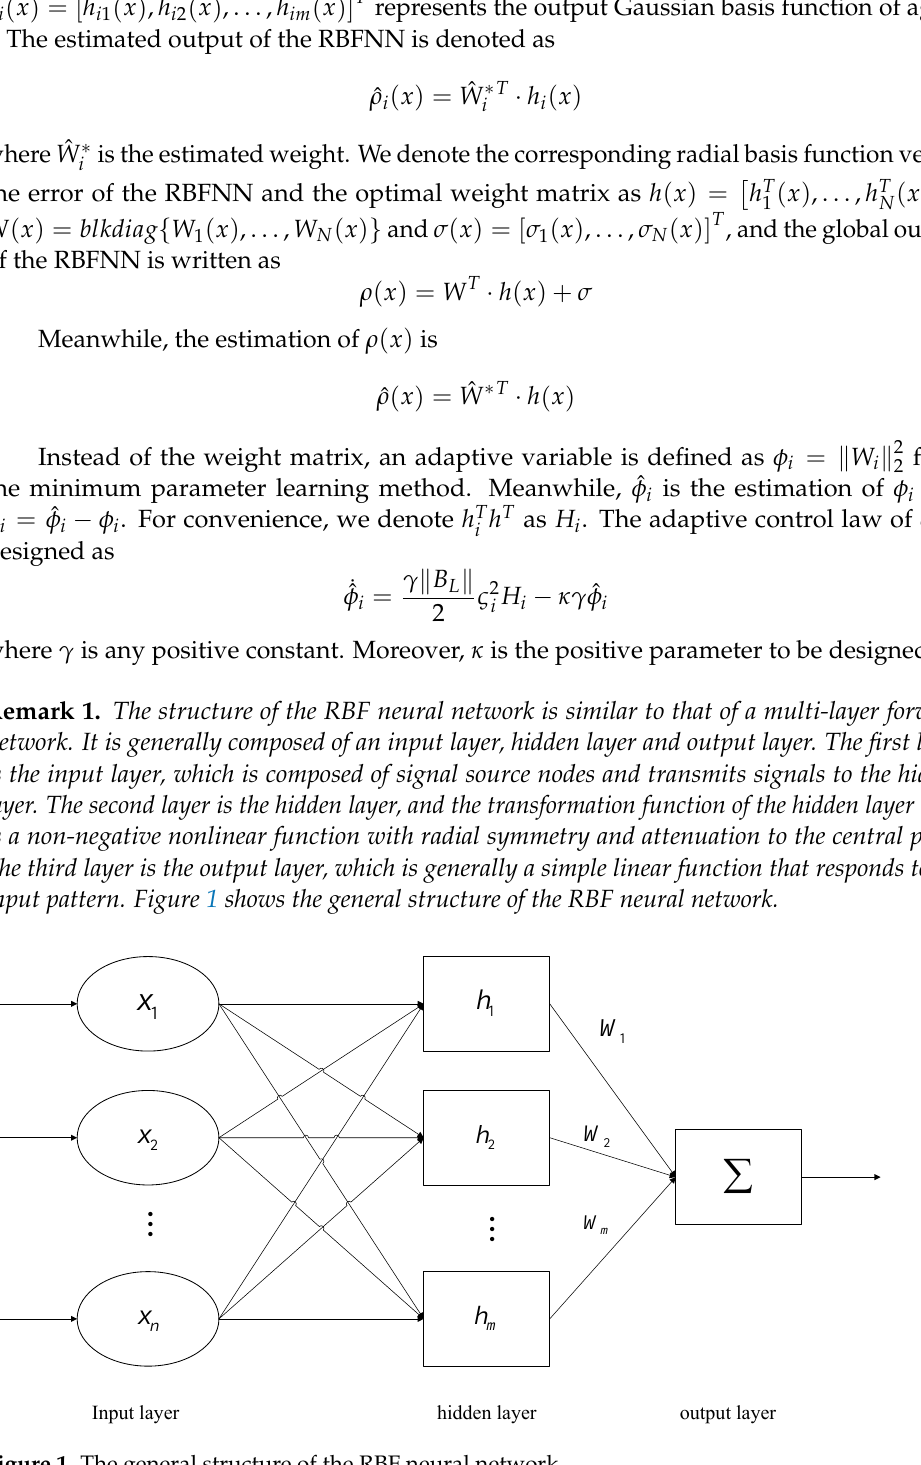
Figure 1. The general structure of the RBF neural